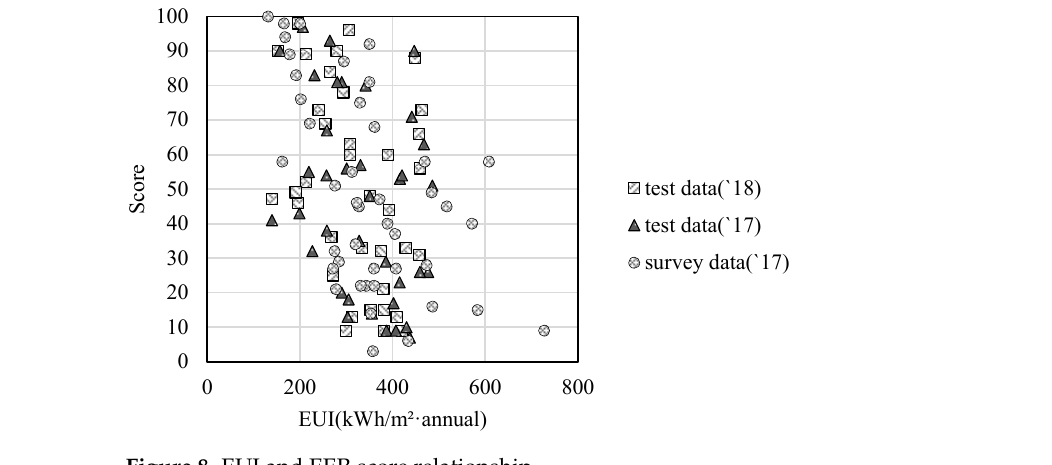
Figure 8. EUI and EER score relationship.